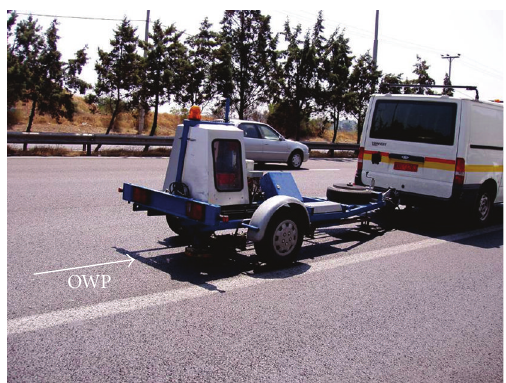
Figure 6: Schematic diagram of an FWD.